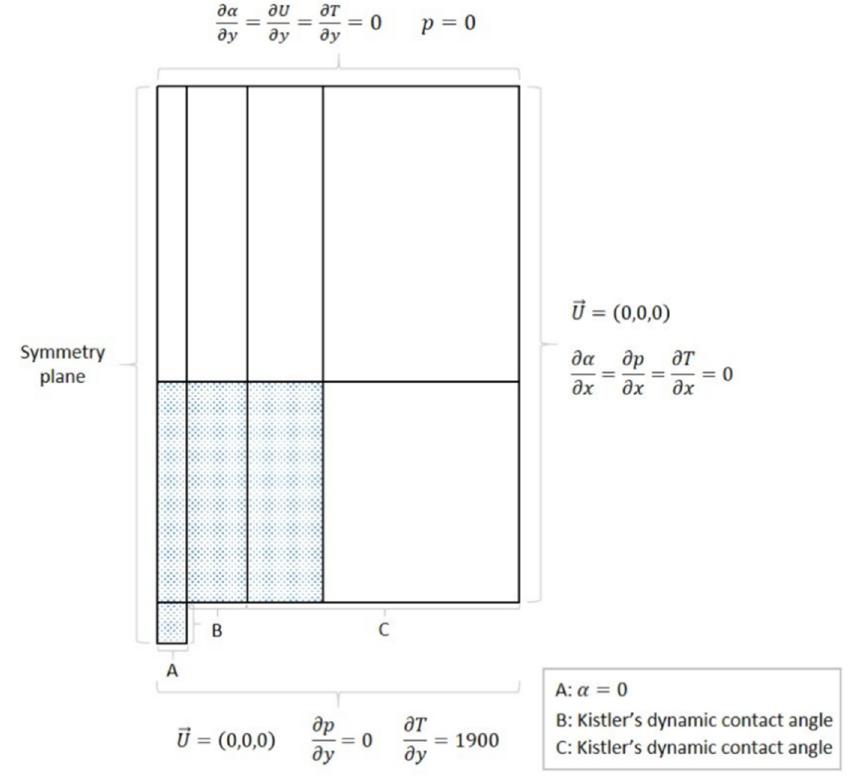
Figure 6. Boundary conditions of the problem.